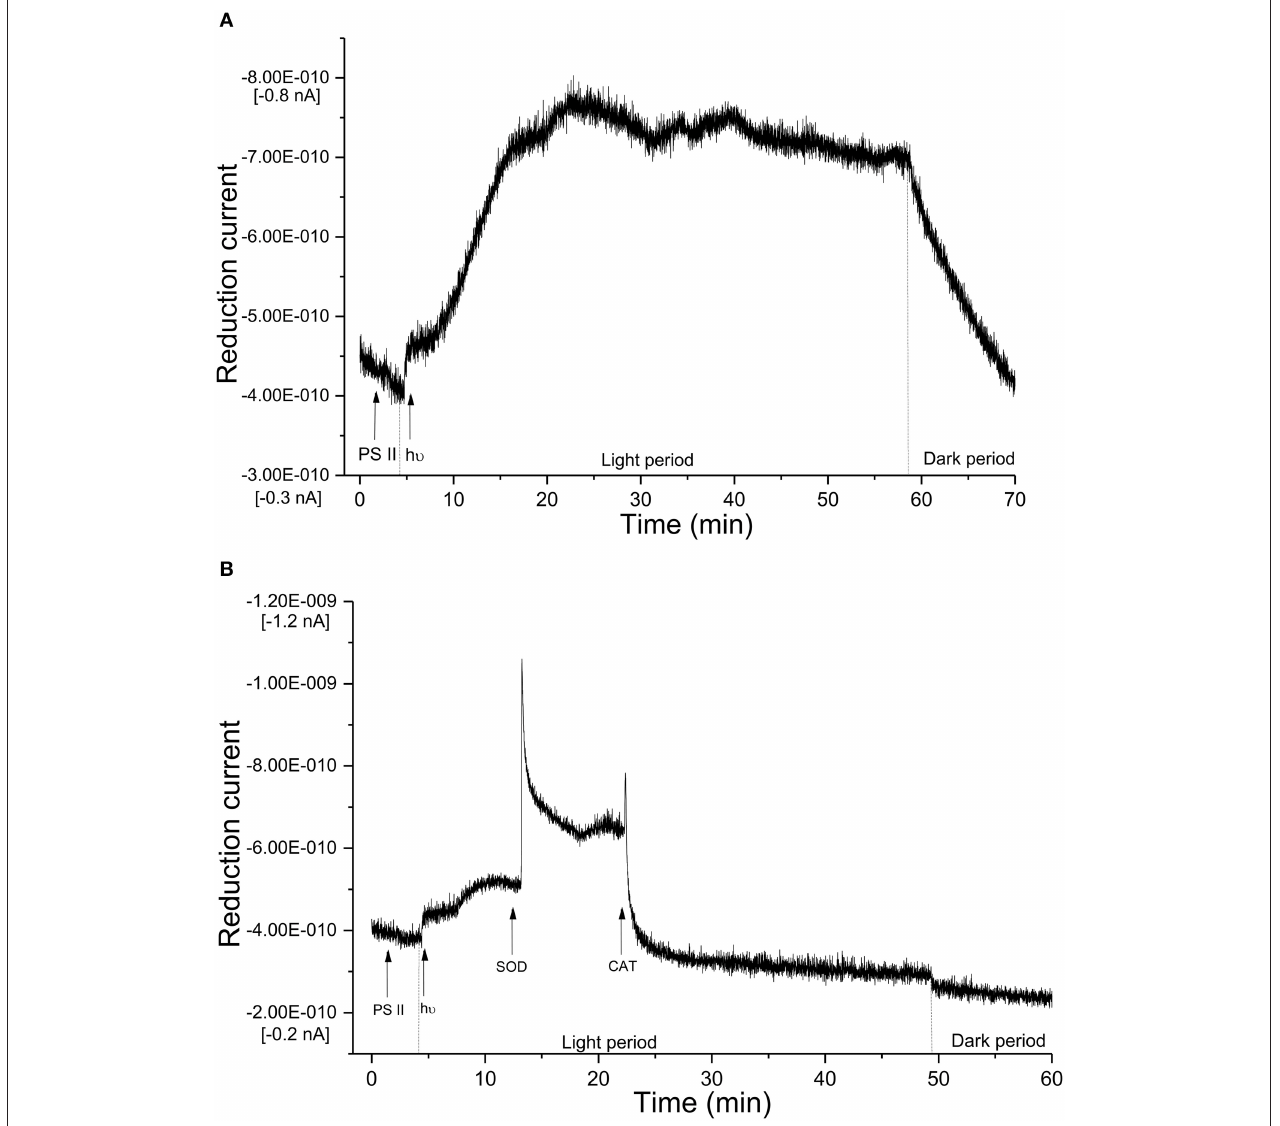
FIGURE 4 | Real-time monitoring of reduction current for hydrogen peroxide in PSII membrane. (A) Kinetics of the production of H 2 O 2 was measured using Os-HRP modified carbon electrode during light illumination in PSII membranes. The light illumination was started at 5min from the start of the measurement and the reduction current was measured for a duration of 1h. (B) Effect of SOD and CAT on reduction current was measured in the presence of SOD (400U/ml) and SOD + CAT (400U/ml